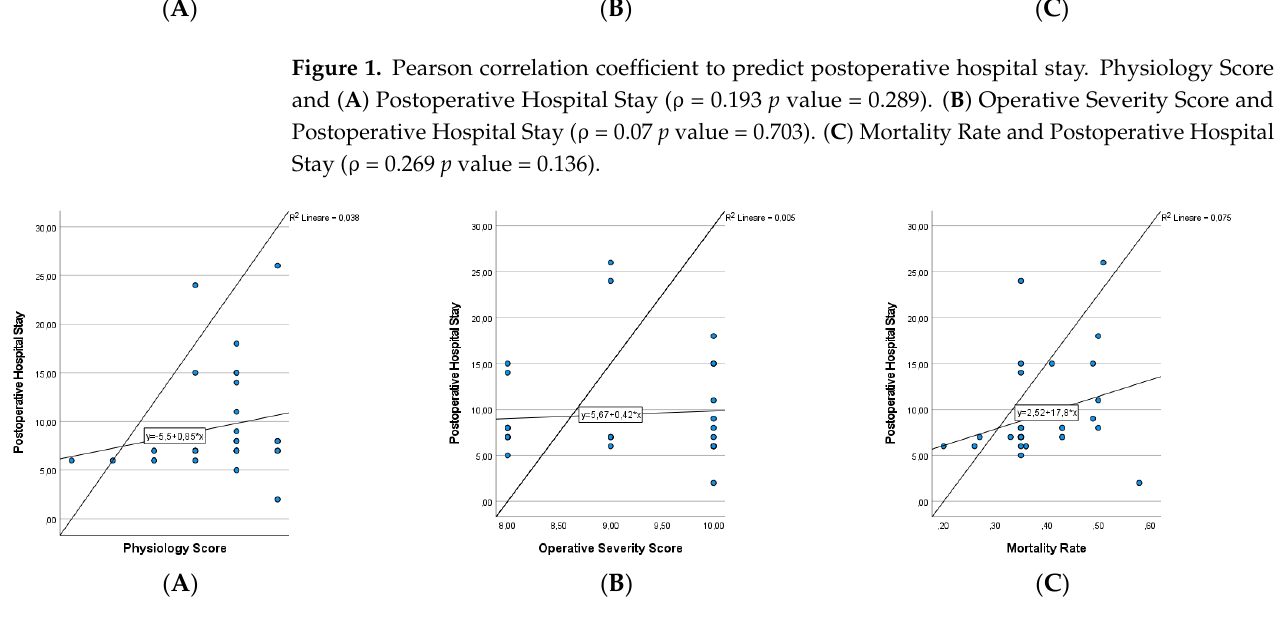
Figure 2. Pearson correlation coefficient to predict postoperative complications according to Clavien Dindo Classification. ( A ) Physiology Score and Clavien Dindo Classification ( ρ = 0.479 p value = 0.05). ( B ) Operative Severity Score and Clavien Dindo Classification ( ρ = − 0.174 p value = 0.340). ( C ) Mortality Rate and and Clavien Dindo Classification ( ρ = 0.399 p value = 0.023).